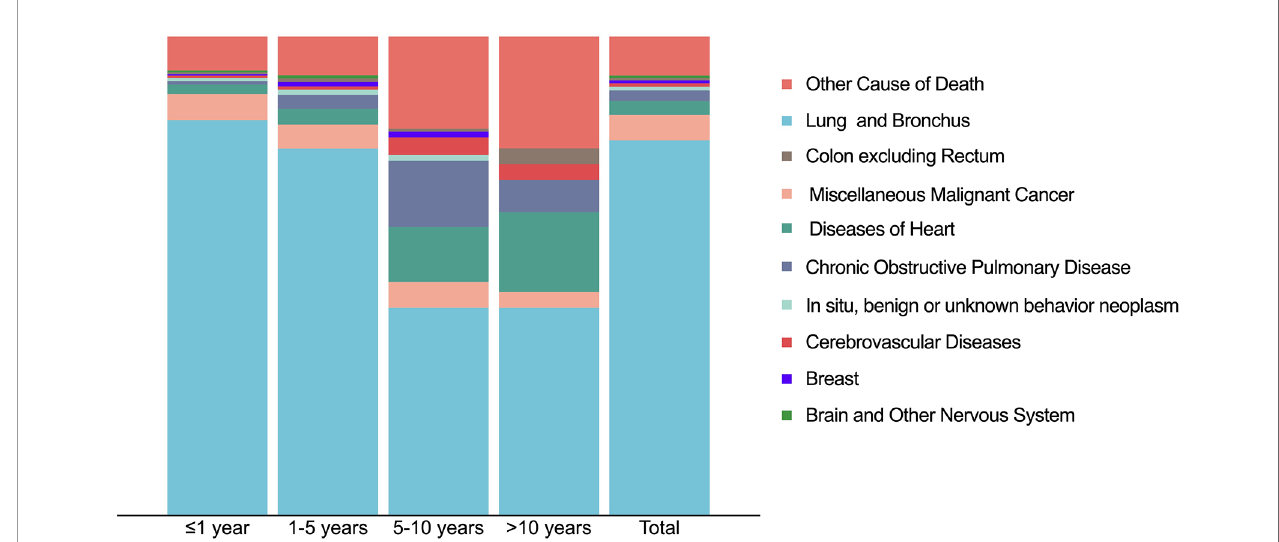
FIGURE 8 | Causes of death distribution in patients with pulmonary large cell neuroendocrine carcinoma using SEER 18 Regs Custom Data (with additional treatment fi elds; November 2018